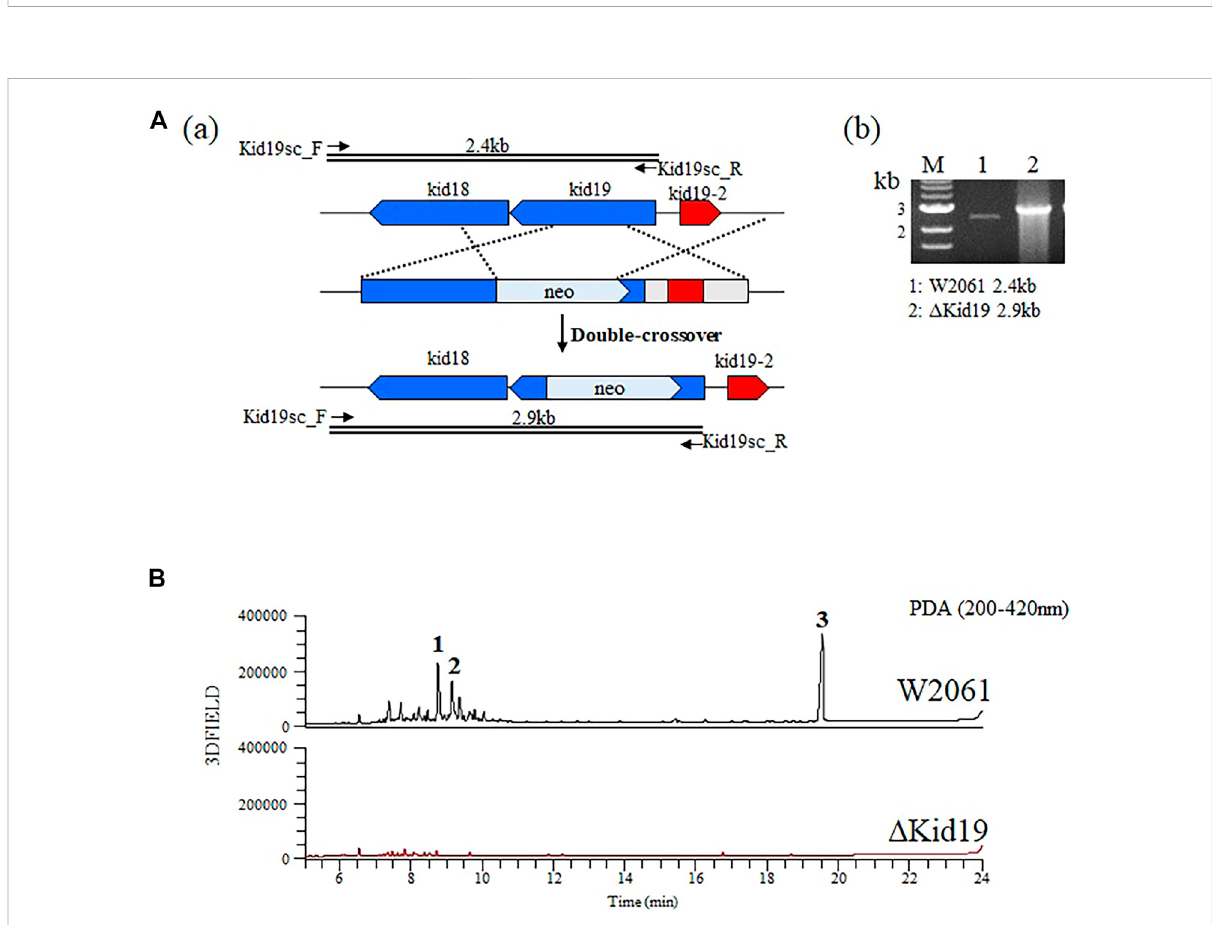
FIGURE 3 Strategies for gene disruption. (A) The Δ Kid19 mutant resulted from a double crossover event to produce a kanamycin-resistant strain in which the kid19 gene was disrupted (a). Con fi rmation of insertional kid19 gene inactivation using PCR and the total genomic DNA of each mutant as the template(b).Theprimers(kid19sc_F&kid19sc_R;SupplementaryTableS2)usedtoamplifythedesiredDNAfragmentsareindicatedbysolidarrows. M, 1 kb ladder; 1,wild type; 2, Δ Kid19 mutant. (B) Comparative HPLC analysis of crude fermentation extracts showing productionof kidamycins ( 1 and 2 )and rubi fl avinoneC-1( 3 )bystrains W2061and Δ Kid19, revealingloss ofkidamycins andrubi fl avinoneC-1 production due to the kid19 gene